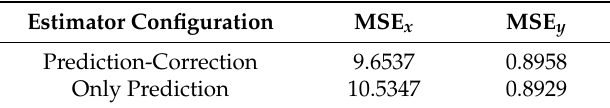
Table 6. Mean square error between trajectories.